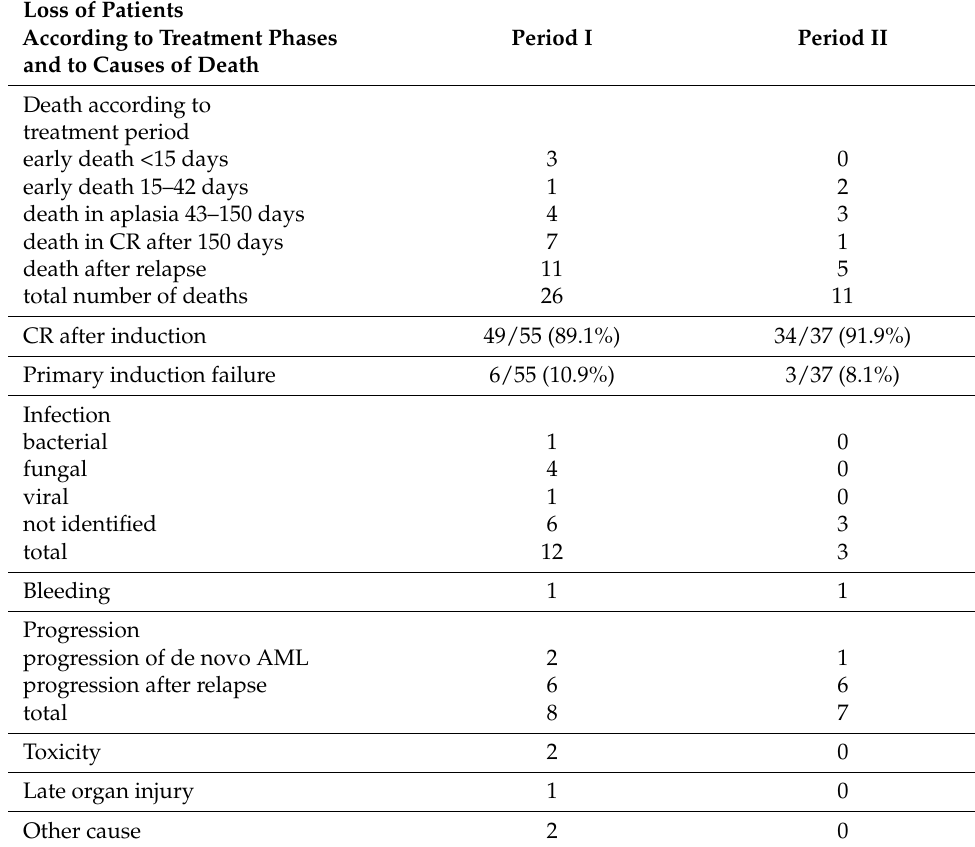
Table 3. Deaths according to treatment and classification of causes of deaths in Period I and Period